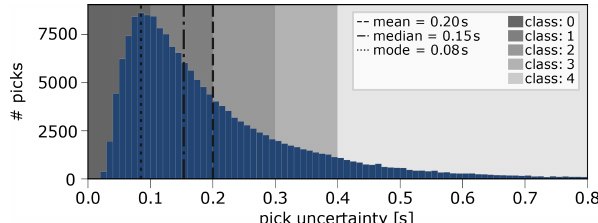
Figure 6. Histogram of uncertainties of the full dataset as shown in detail in Paffrath et al. (2021a). Mean and median of uncertainties are indicated by vertical lines, as well as the bin with the highest number of pick